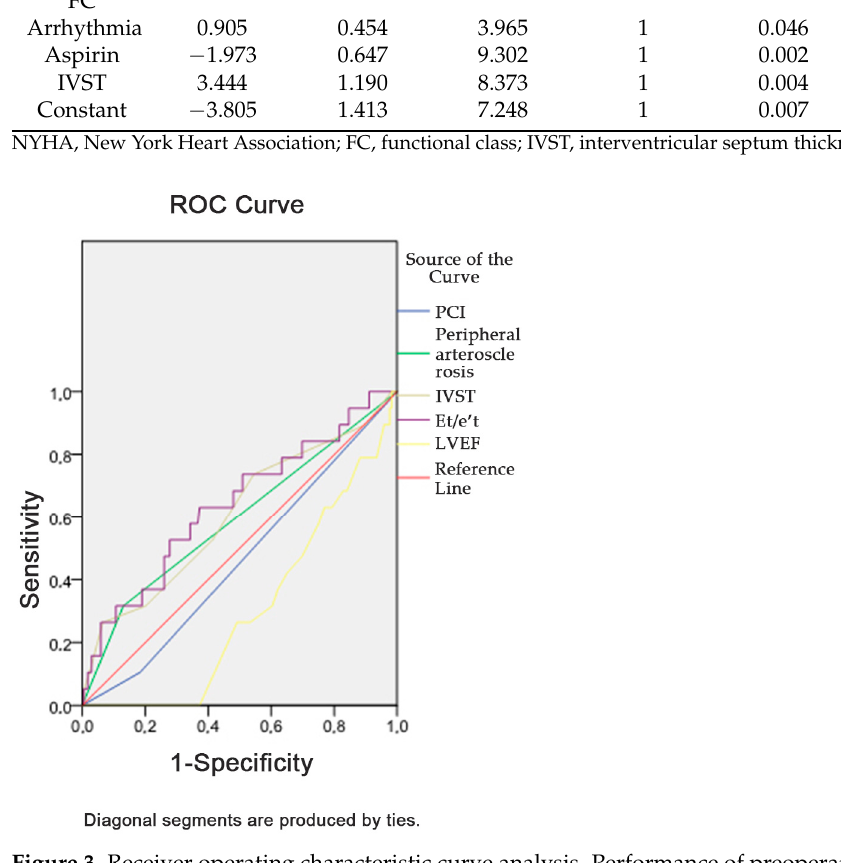
Figure 3. Receiver operating characteristic curve analysis. Performance of preoperative parameters in discriminating the risk of MACE development 18 months after CABG. Notes: ROC, receiver operating characteristic; Et/e’t, ratio of early transtricuspid diastolic filling to the early diastolic tricuspid annular tissue velocity; LVEF, left ventricular ejection fraction; IVST, thickness of the interventricular septum; PCI, percutaneous coronary intervention; TAPSE, tricuspid annular plane systolic